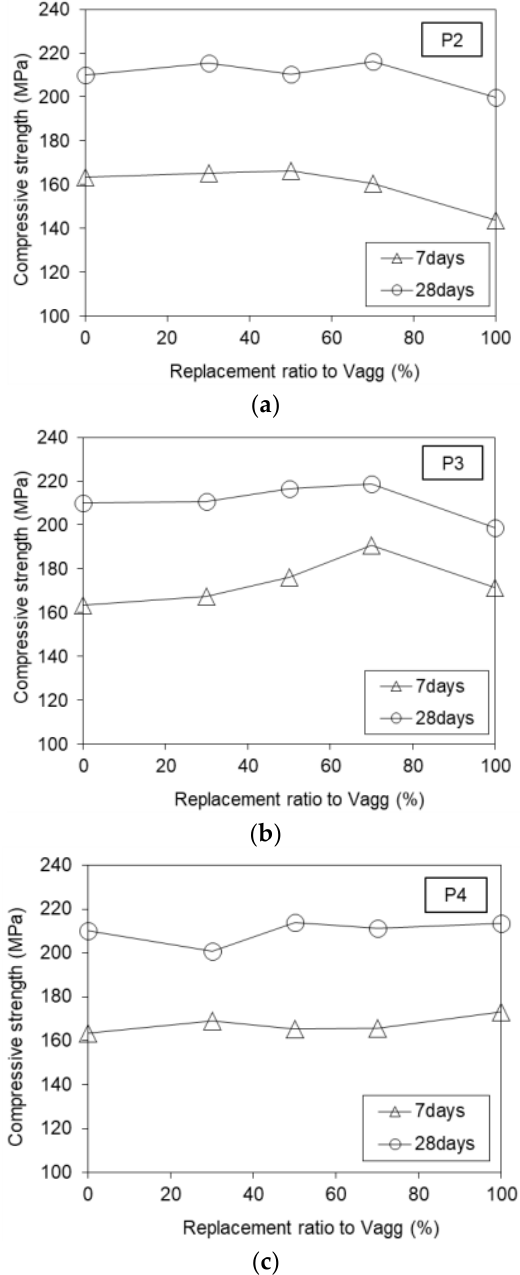
Figure 19. Effect of P2, P3, and P4 addition ratios on compressive strength. ( a ) P2. ( b ) P3. ( c ) P4.